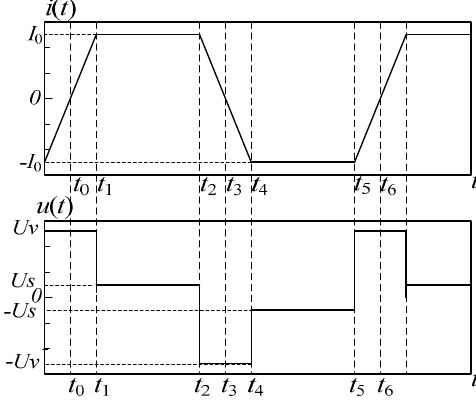
Figure 2. Expected waveforms of load current and voltage.